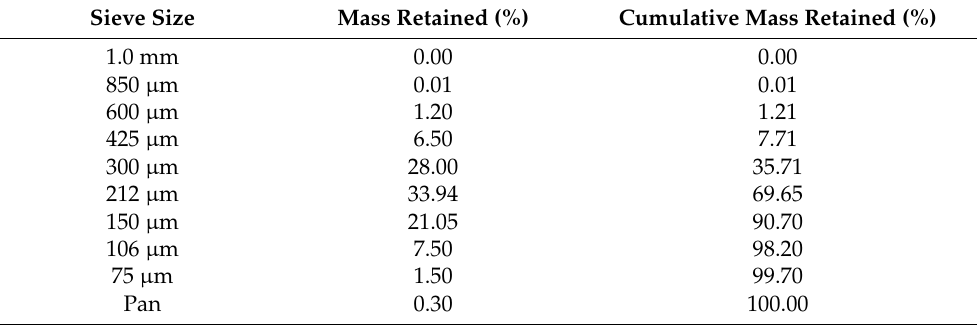
Table 2. Sieve analysis of sand